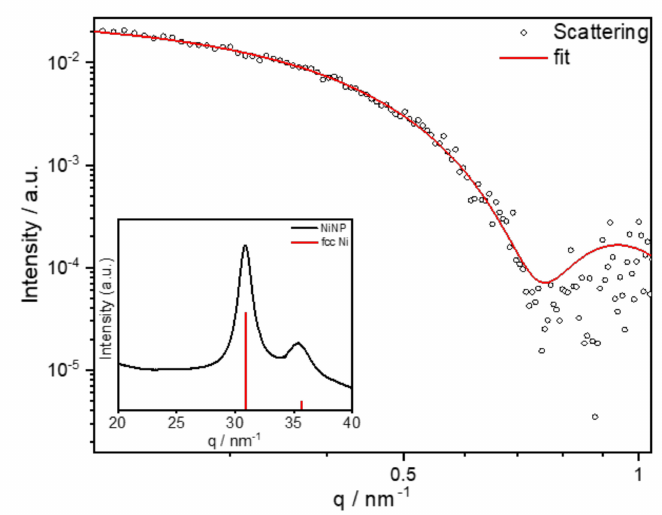
Figure 2. SAXS data of nickel nanoparticles dispersed in hexane with a curve fit according to a homogenous sphere with a Schulz–Zimm size distribution resulting in 11.8 nm, polydispersity 8%; (inset) XRD of NiNPs (black) as compared to the database entry JCPDS database PDF 04-0850 (red) for bulk nickel.